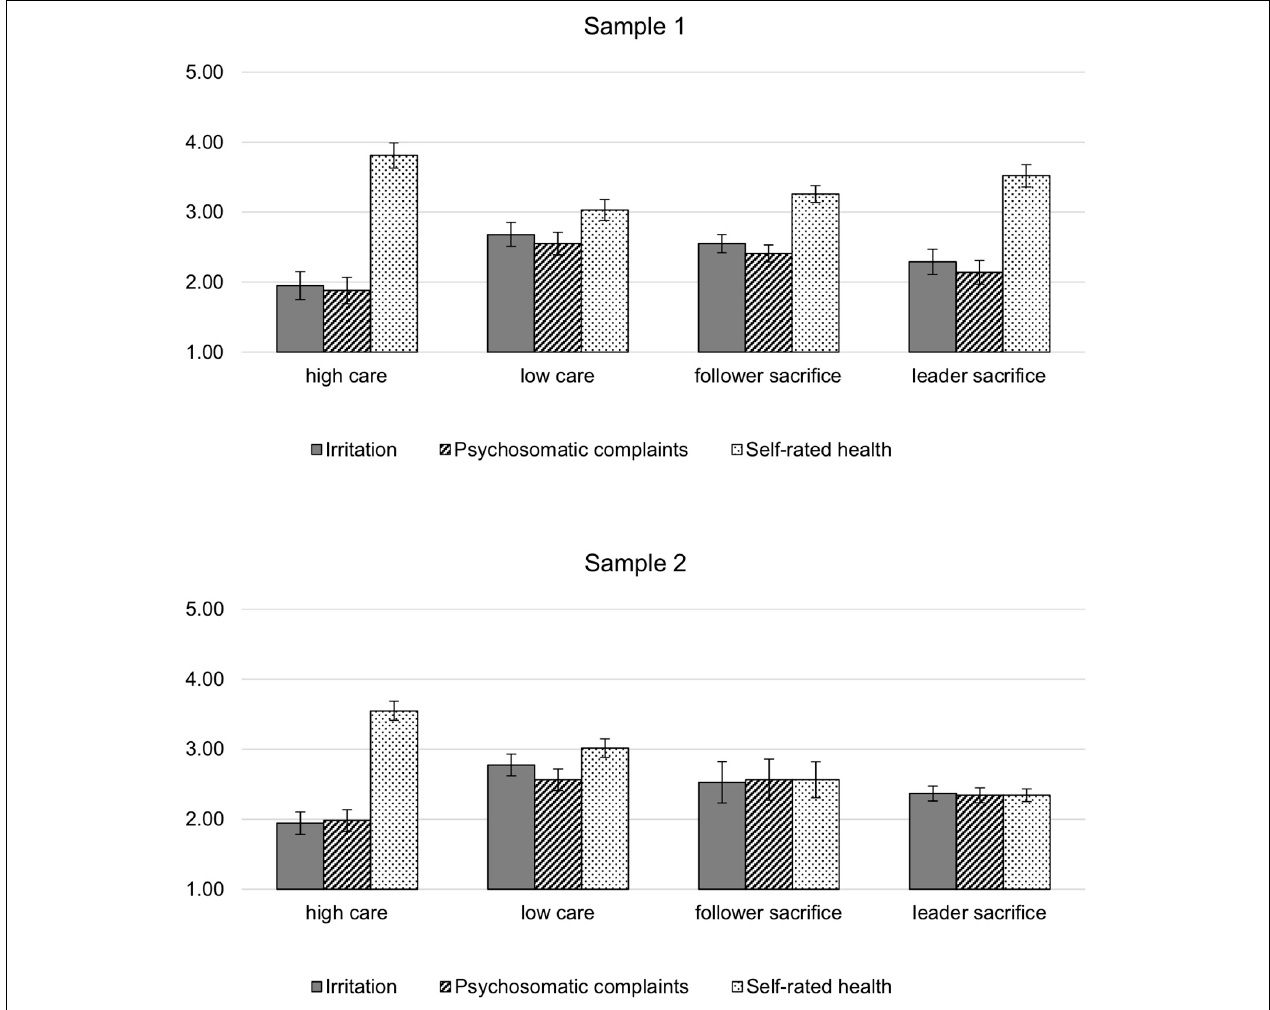
FIGURE 2 | Mean scores and 95%-confidence intervals of irritation, psychosomatic complaints and self-rated health across the four profiles of health-oriented